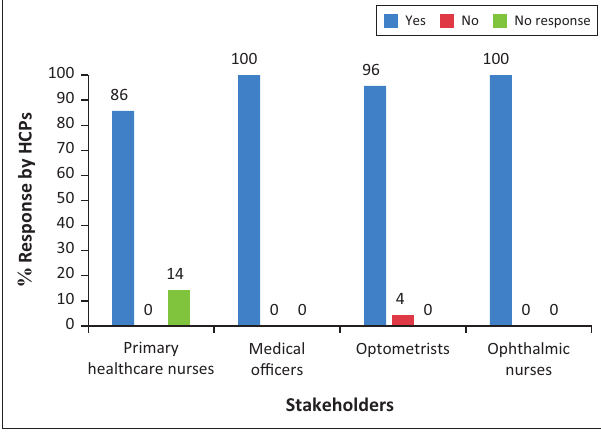
HCP, healthcare practitioners. FIGURE 4: Percentage of responses by healthcare practitioners in understanding the referral